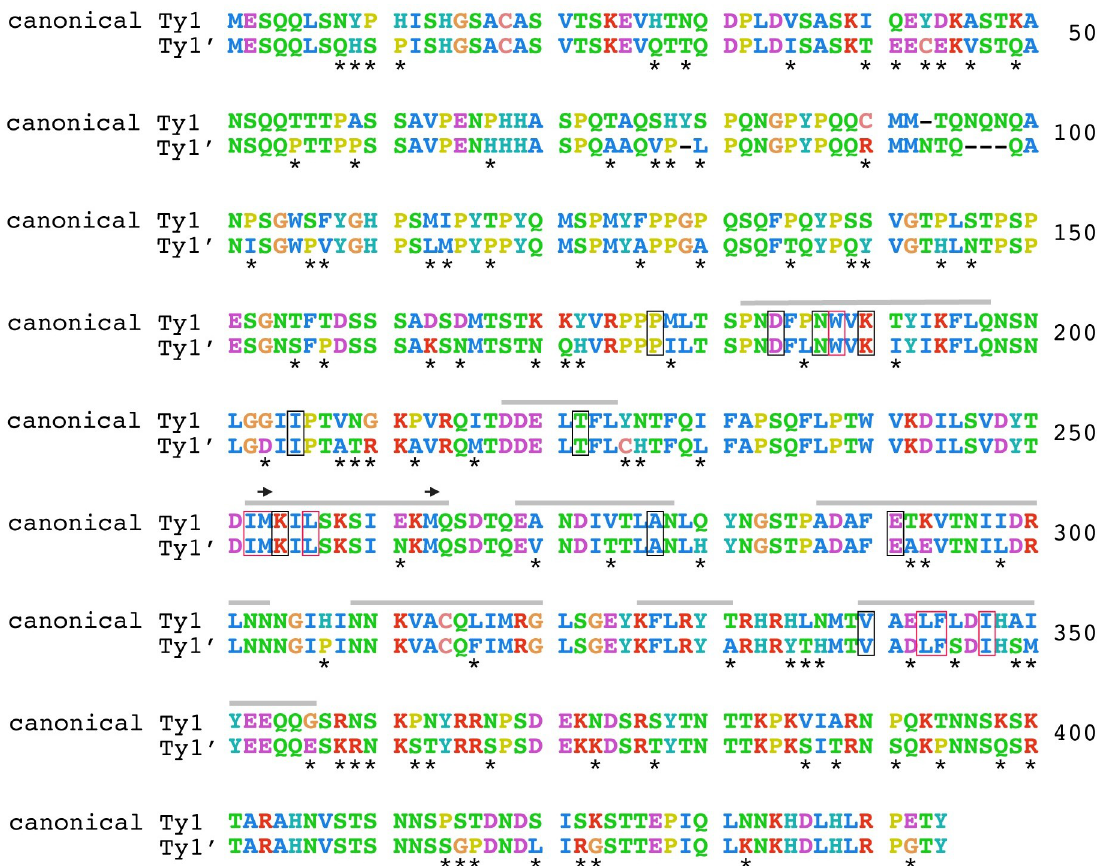
Fig 5. Amino acid divergence between ancestral canonical Ty1 and ancestral Ty1’ gag sequences. Codon-based alignment of maximum likelihood reconstructed ancestral states of all S . cerevisiae canonical Ty1 and all Ty1’ gag sequences, respectively, excluding two elements that are recombinant in gag (Y12_f109 and S288c_f486). Amino acids with similar properties were colorized as follows: KR (positively charged) = red; AFILMVW (hydrophobic side chains) = blue; NQST (polar uncharged side chains) = green; HY = teal; C = salmon; DE (negatively charged) = purple; P = yellow; G = orange. Amino acid substitutions between ancestral sequences are denoted by asterisks. Amino acids sites in Ty1 Gag with known function [32,35] are annotated as follows: sites that cause resistance to p22-based CNC are shown in black boxes; sites that are important for Ty1 protein maturation are shown in red boxes; grey bars represent predicted helical regions; and alternative start codons for p22 are shown as arrows.